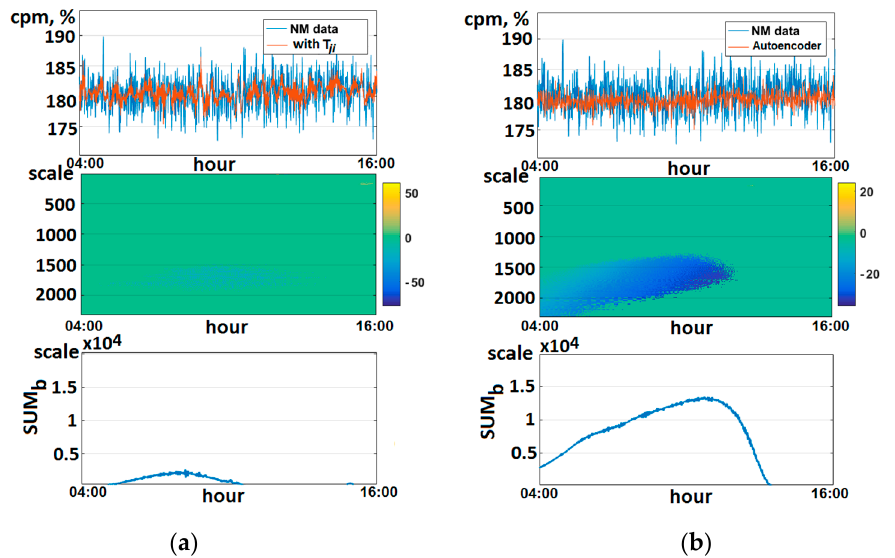
= = 2.5 ∗ σ l ; (cid:3284) j i i